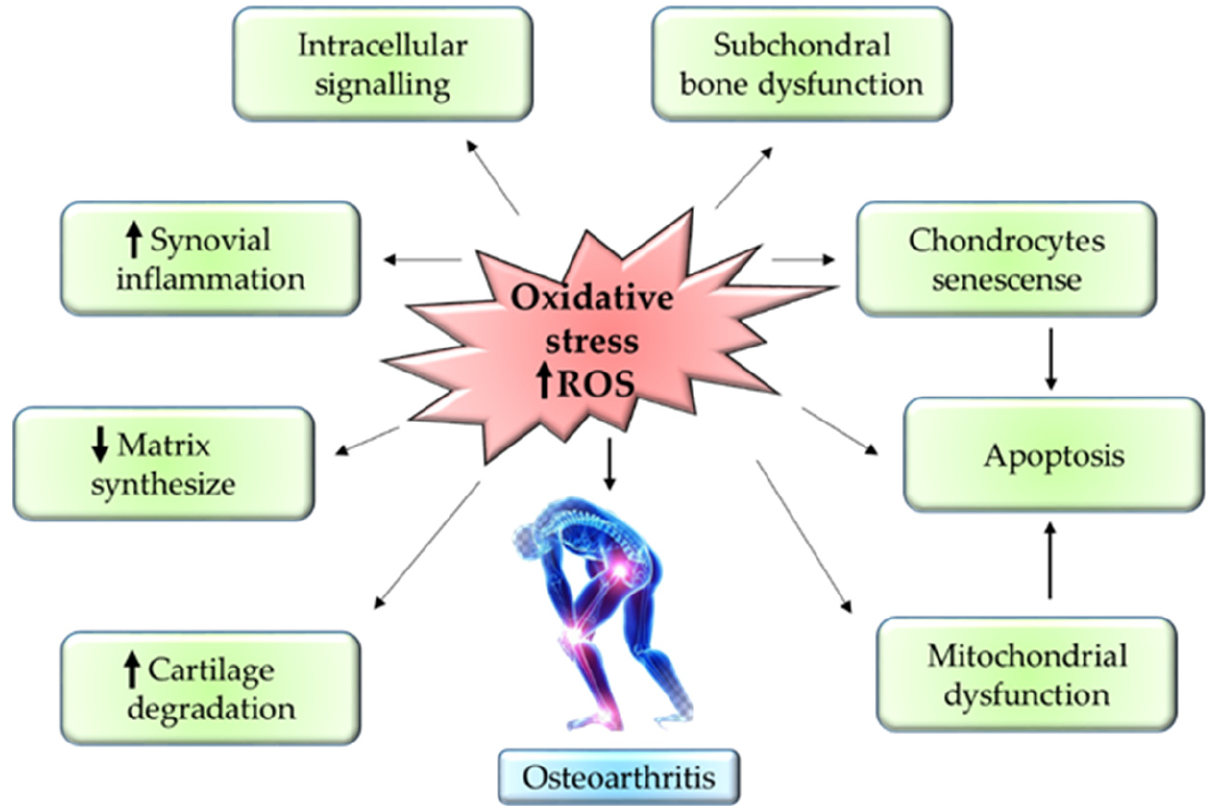
Figure 3. Mechanism of oxidative stress in OA pathogenesis .